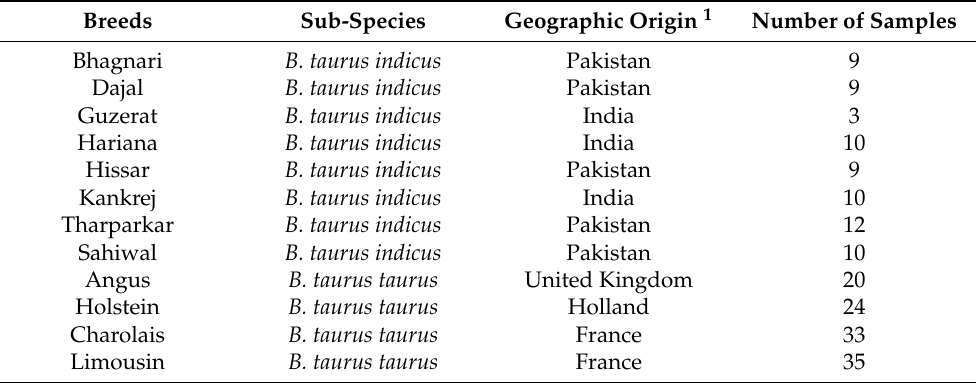
Table 1. List of breeds used in this study including the subspecies, the geographic origin 1 and the number of